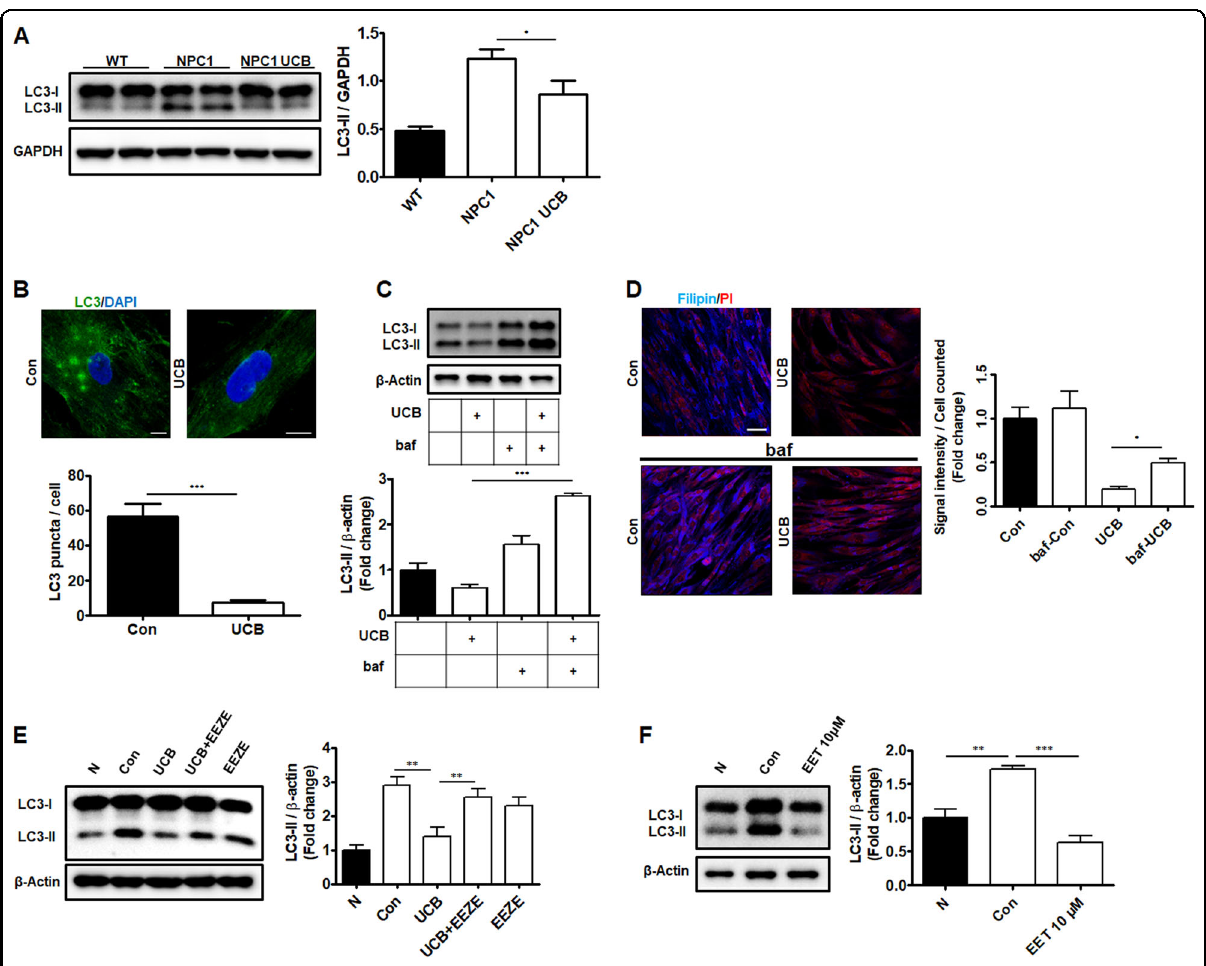
Fig. 6 Therapeutic effect of 14,15-EET is regulated by autophagy signaling. a Western blot analysis showing the expression pattern of LC3 protein in the cerebella of 8-week-old WT, NPC1-mutant mice (NPC1) and NPC1-mutant mice treated with hUCB-MSCs intranasally (NPC1-UCB). b The results of NPC1 patient fi broblasts (Con) and NPC1 patient fi broblasts cultured with hUCB-MSCs (UCB) were compared using immunohistochemistry via staining with LC3. c Protein levels of LC3 in NPC1 patient fi broblasts, treated with or without hUCB-MSCs for 72 h, in the presence or absence of 400 nM bafA 1 for the last 4 h are shown. d The results of fi lipin staining on NPC1 patient fi broblasts (Con), treated with or without hUCB-MSCs for 72 h (UCB), in the presence or absence of 400 nM bafA 1 for the last 4 h (baf-Con, baf-UCB) are shown. e The quanti fi cation of LC3 protein was analyzed in normal fi broblasts (N), NPC1 patient fi broblasts (Con), hUCB-MSC-treated NPC1 patient fi broblasts (UCB), hUCB-MSC-co-treated and EEZE-co-treated NPC1 patient fi broblasts (UCB EEZE), and EEZE-treated NPC1 patient fi broblasts (EEZE). f LC3 protein levels in normal fi broblasts (N), NPC1 patient fi broblasts (Con), and 14,15-EET-treated (10 μ M) NPC1 fi broblasts (EET 10 μ M) were also analyzed. Scale bars = 50 μ m. All data represent the mean ± SD. * P < 0.05; ** P < 0.01; *** P <